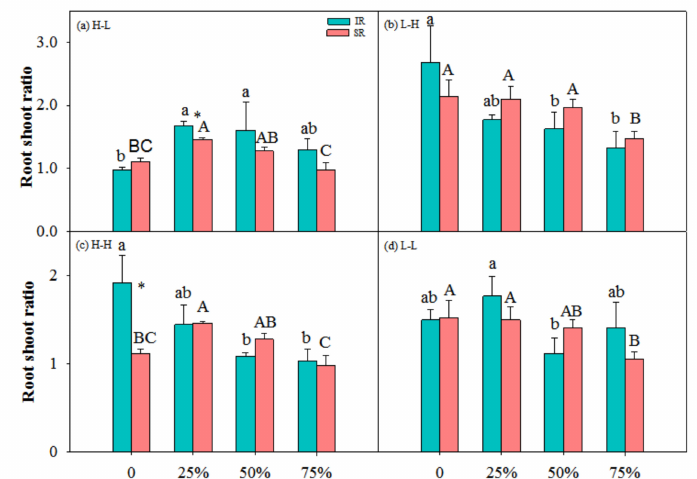
Figure 4. Root shoot biomass ratio of ramets with intact rhizome (IR) and severed rhizome (SR) with increasing clipping levels in di ff erent nutrient treatments. ( a ) H-L, ( b ) L-H, ( c ) H-H and ( d ) L-L indicate high-low, low-high, high-high and low-low nutrient treatments, respectively. The error bars represent standard errors (SE), and bars with di ff erent lower-case and upper-case letters indicate significant di ff erence among clipping levels for ramets with intact and severed rhizome, respectively ( p < 0.05). *—significant di ff erence between ramets with IR vs. SR at the same clipping